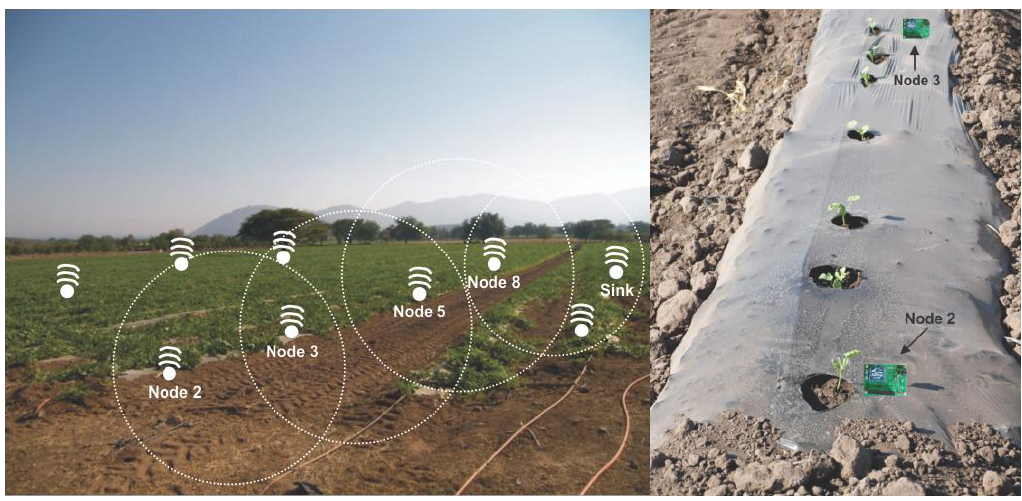
Figure 6. Scenario